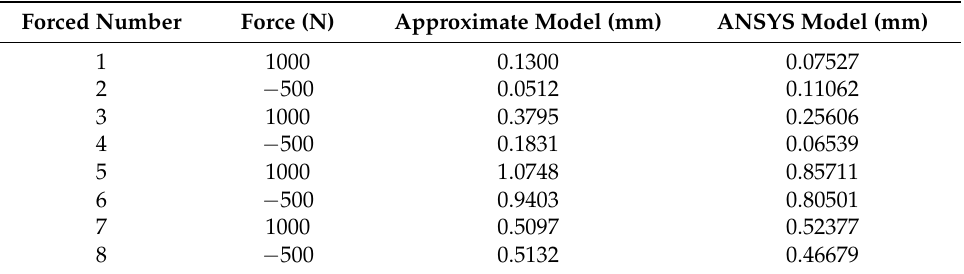
Table 2. Comparison of the approximate model and the ANSYS